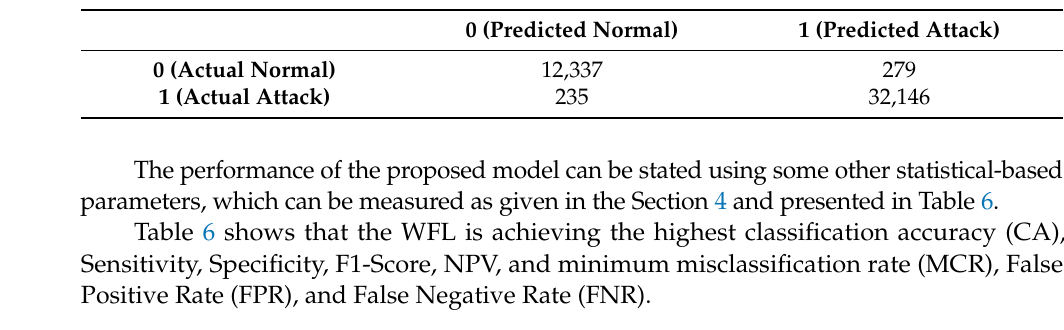
Table 5. Confusion matrix of federated model.